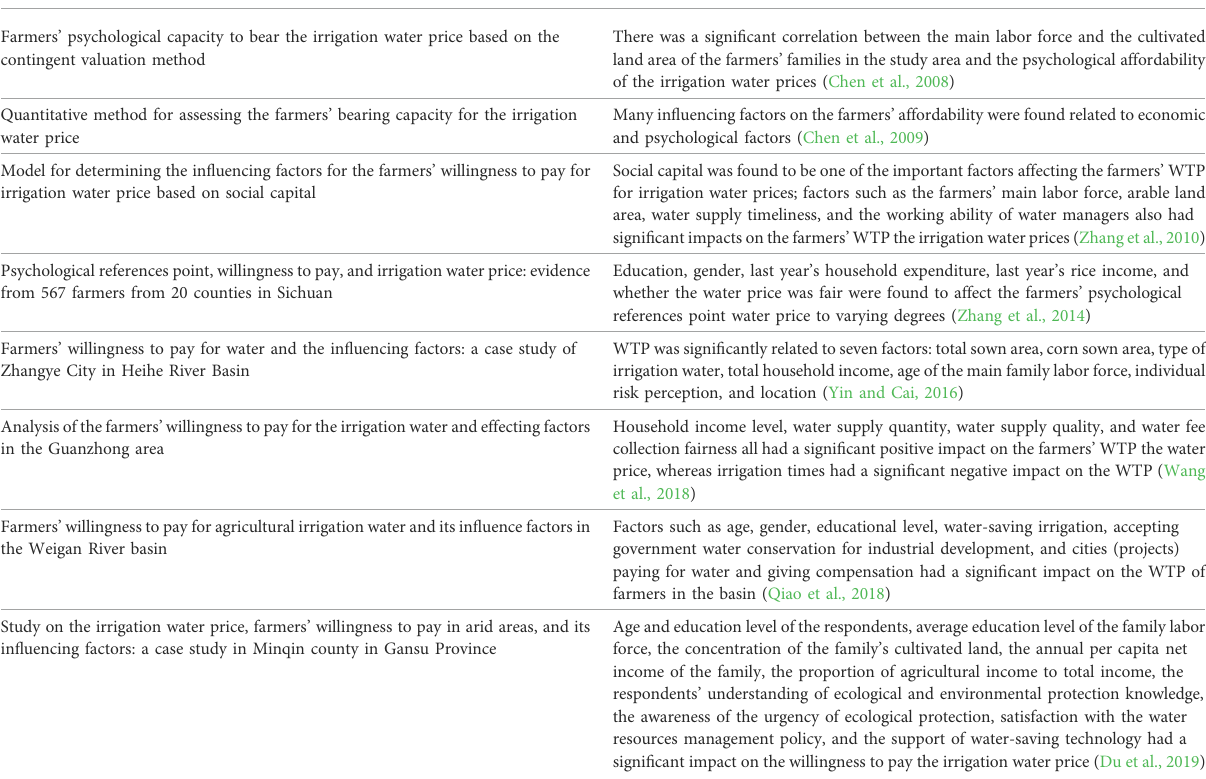
TABLE 1 Research progress on the WTP and agricultural water price